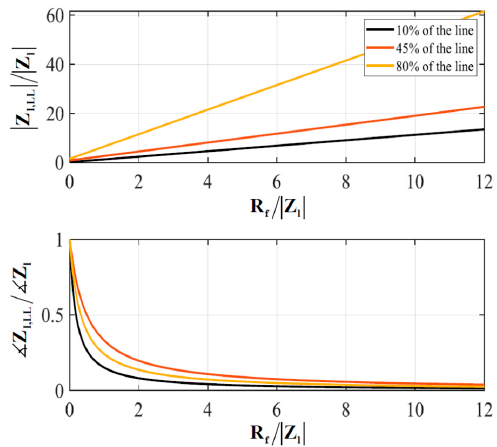
Figure 7. Transformed ( a ) SPS and ( b ) SNS circuit to equivalent delta.